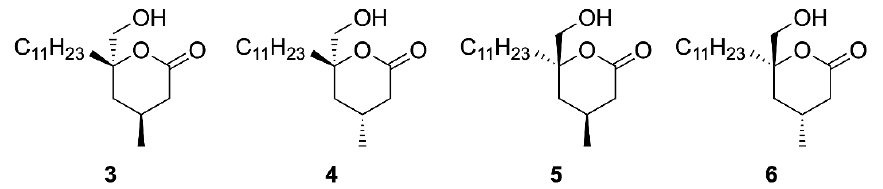
Figure 2. β -Methyl-(+)-tanikolide based analogues 3 – 6 . Table 1. Antibacterial activity of 3 – 6 — MIC and MBC results (triplicates) [a].